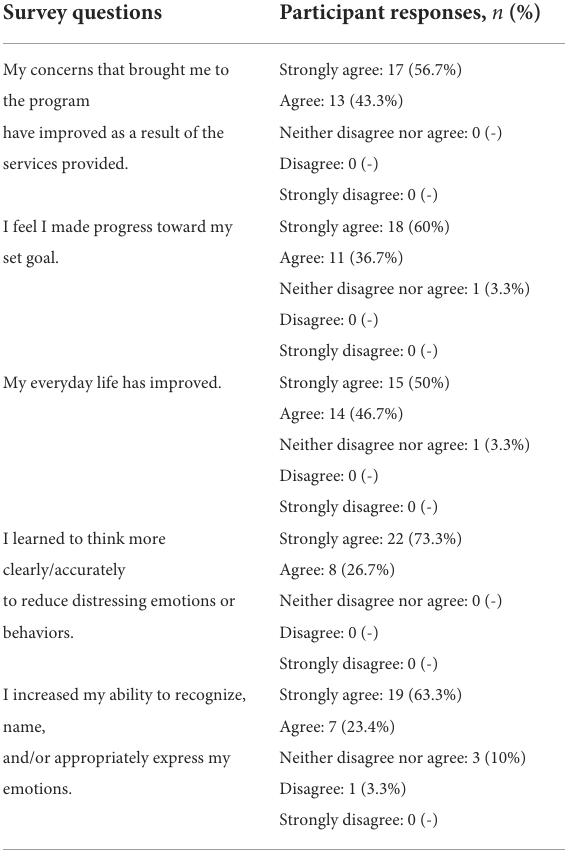
TABLE 4 Participant responses to the self-assessment questionnaire. Survey questions Participant responses, n